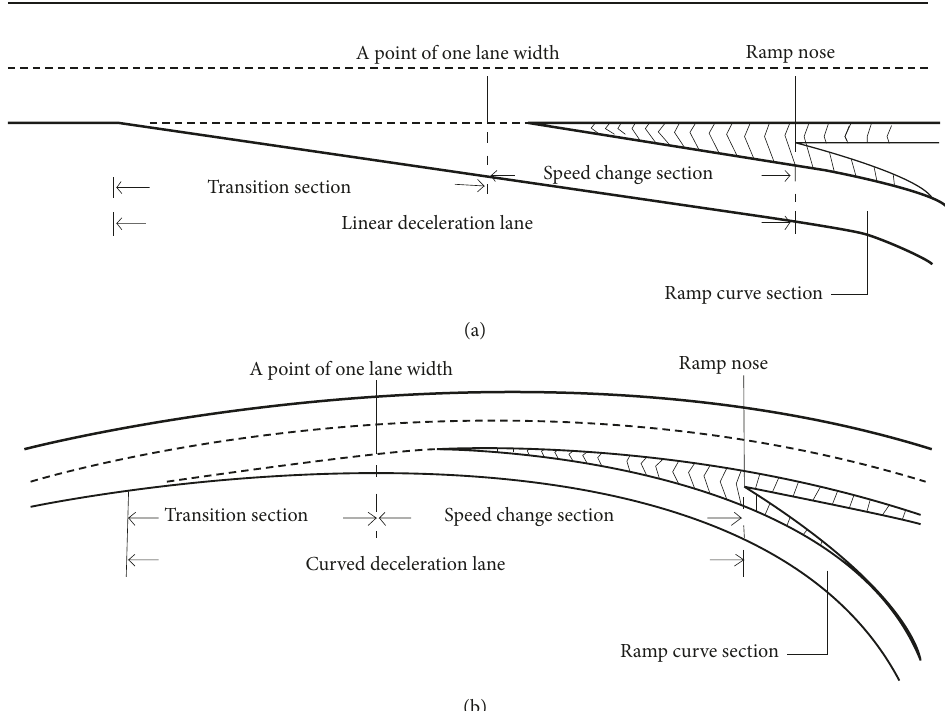
Figure 1: Schematic diagram of the study area of the RPM at the exit of the expressway: (a) freeway exit ramp (straight mainline); (b) freeway exit ramp (curved